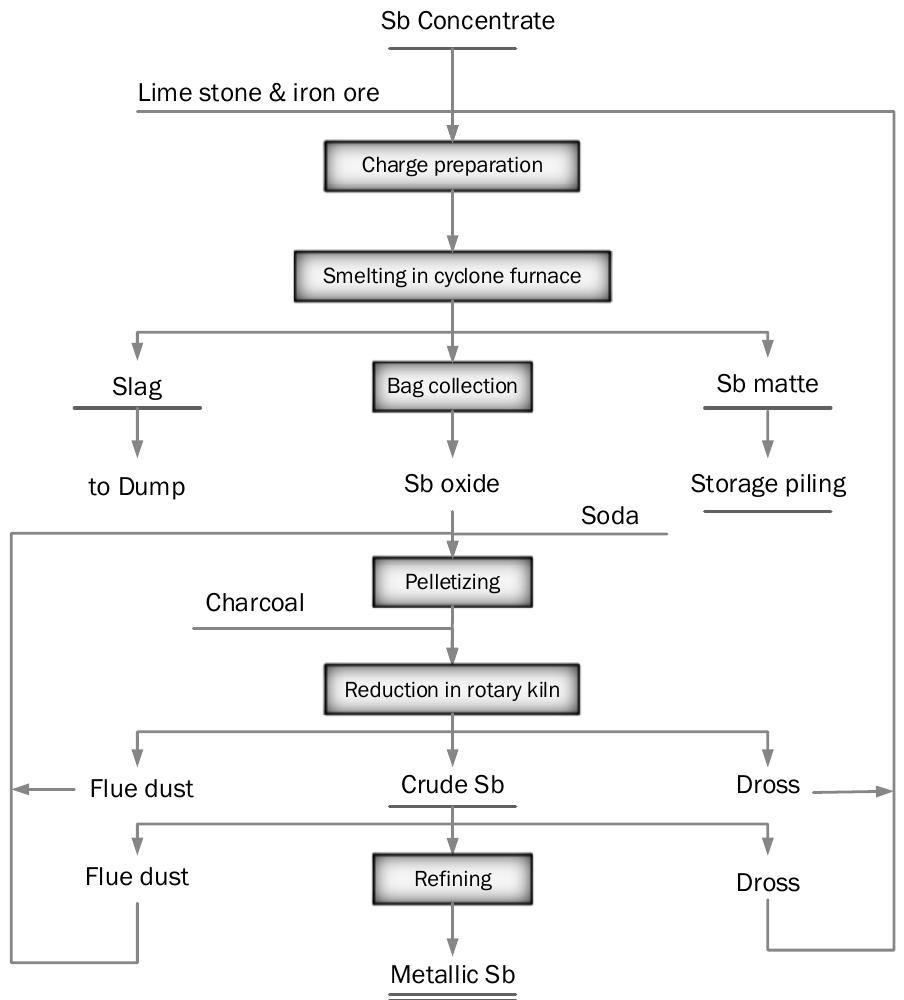
Figure 9. Flow diagram of antimony recovery in cyclone smelting at Vinto smelter in Bolivia (adapted from [4]).